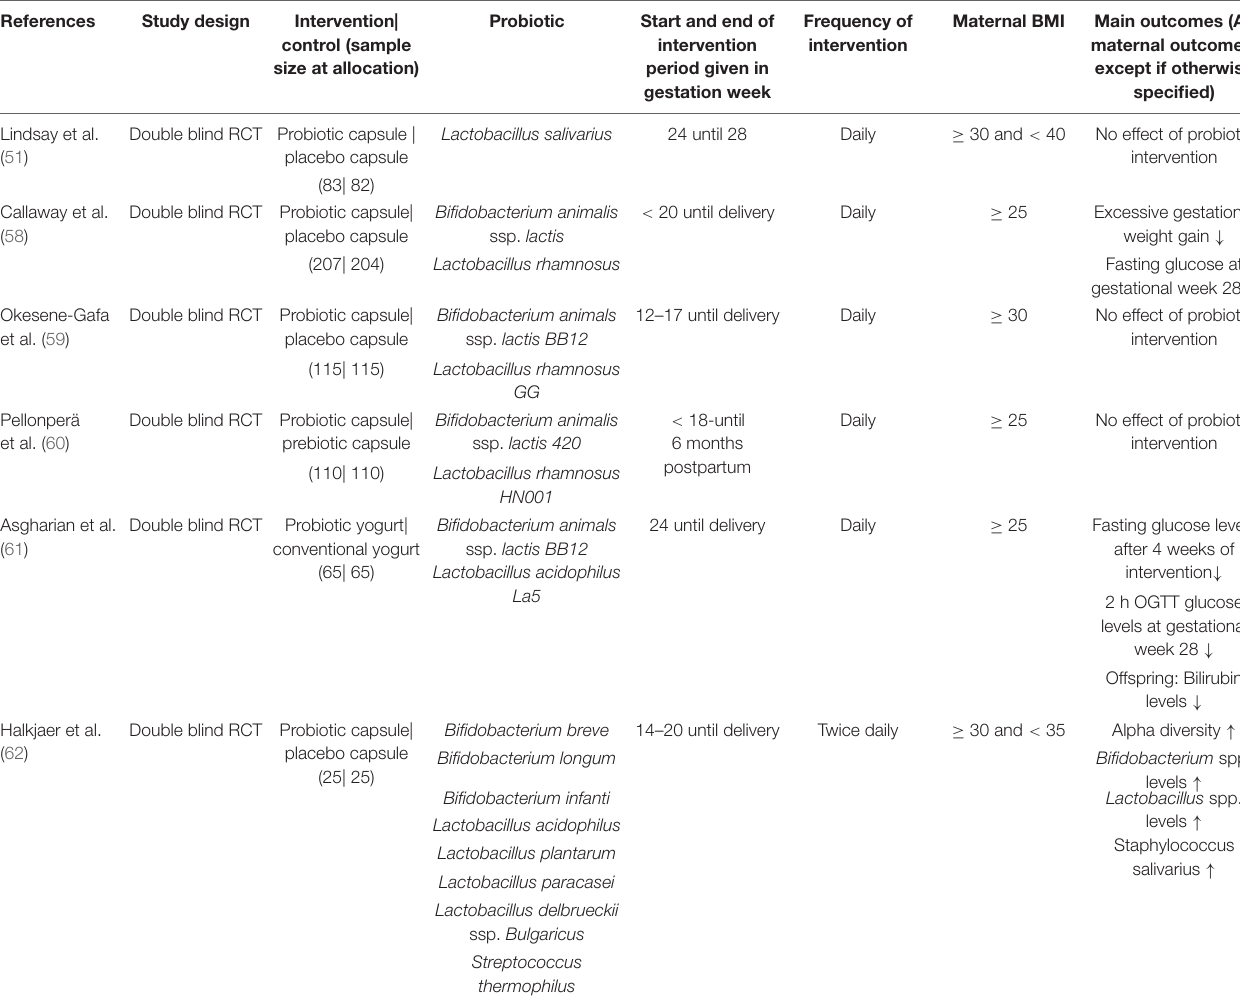
TABLE 2 | Overview of all included human studies, investigating the effect of probiotic supplementation during obese pregnancy a